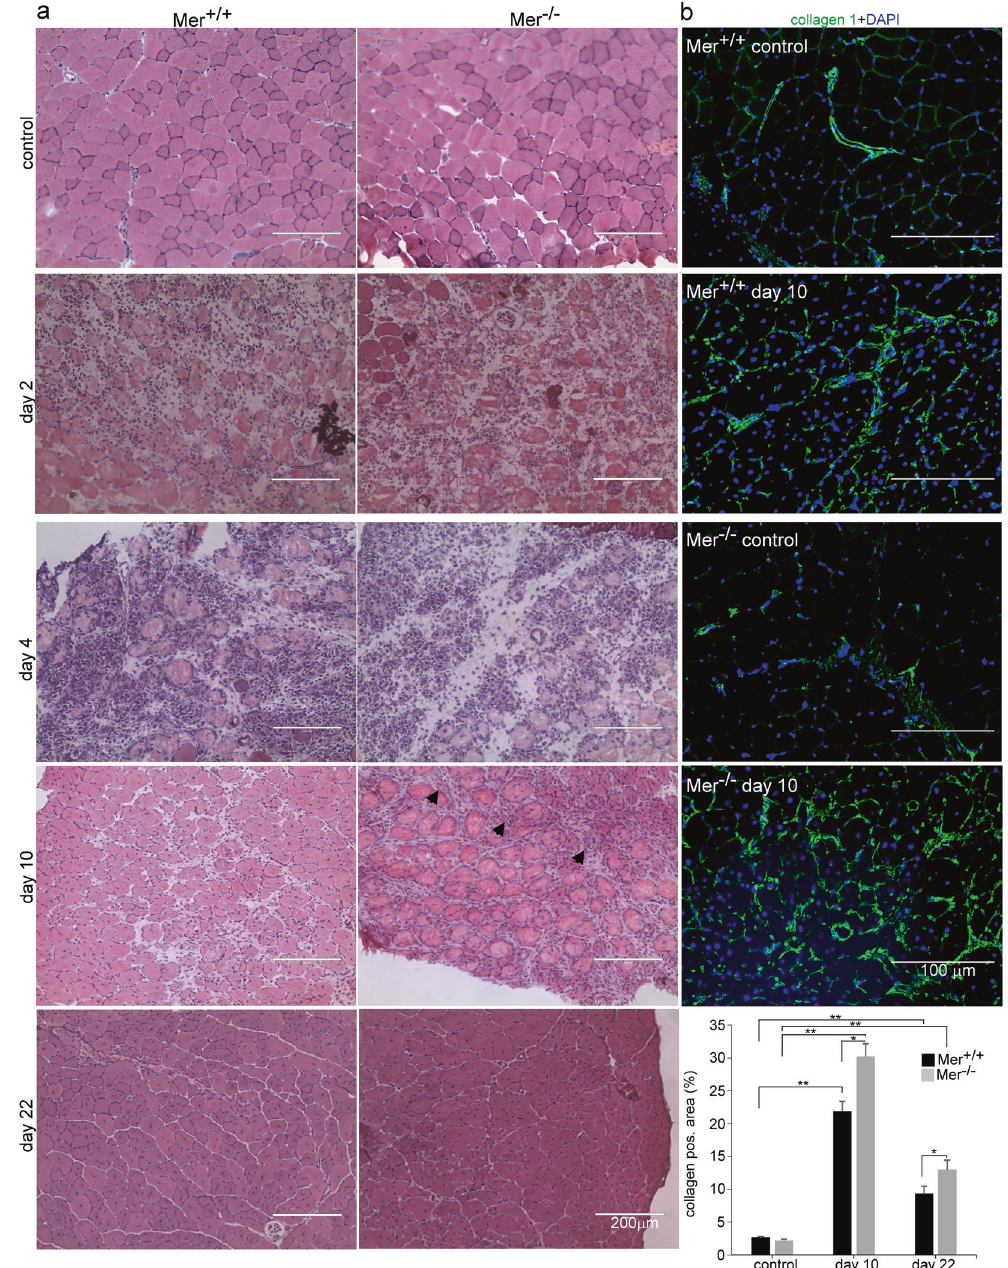
Fig. 4 Time-dependent histological morphology and collagen deposition of TA muscles following cardiotoxin-induced injury in Mer + / + and Mer − / − mice. a Representative H&E stained cross-sections of Mer + / + and Mer − / − TA muscles without treatment and at 2, 4, 10 and 22 post CTX-induced injury ( n = 4, except at day 10, when n = 6). Arrows indicate necrotic areas. Scale bars, 200 μ m. b Representative immuno fl uorescence images of type 1 collagen (green) and DAPI (blue) nuclear staining in control and in Mer + / + and Mer − / − TA muscles regenerating for 10 days, and quanti fi cation of collagen 1-positive areas in the control and in the regenerating muscles of Mer + / + and Mer − / − mice at days 10 and 22 post CTX-induced injury. All data are expressed as mean ± SEM ( n = 4 in controls and n = 6 in the CTX-treated muscles). Asterisks indicate statistical signi fi cance (* P < 0.05, ** P < 0.01, ANOVA